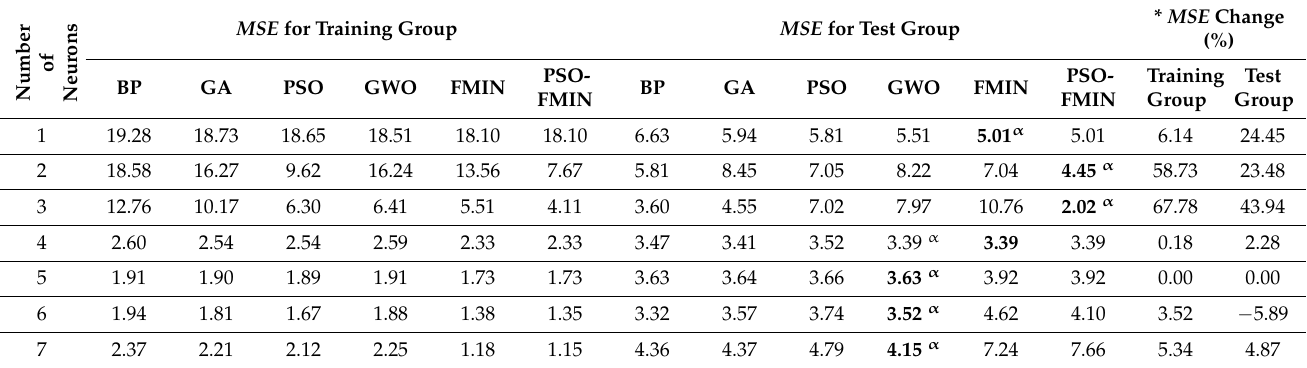
Table 4. Obtained results for the prediction of the l * color coordinate.